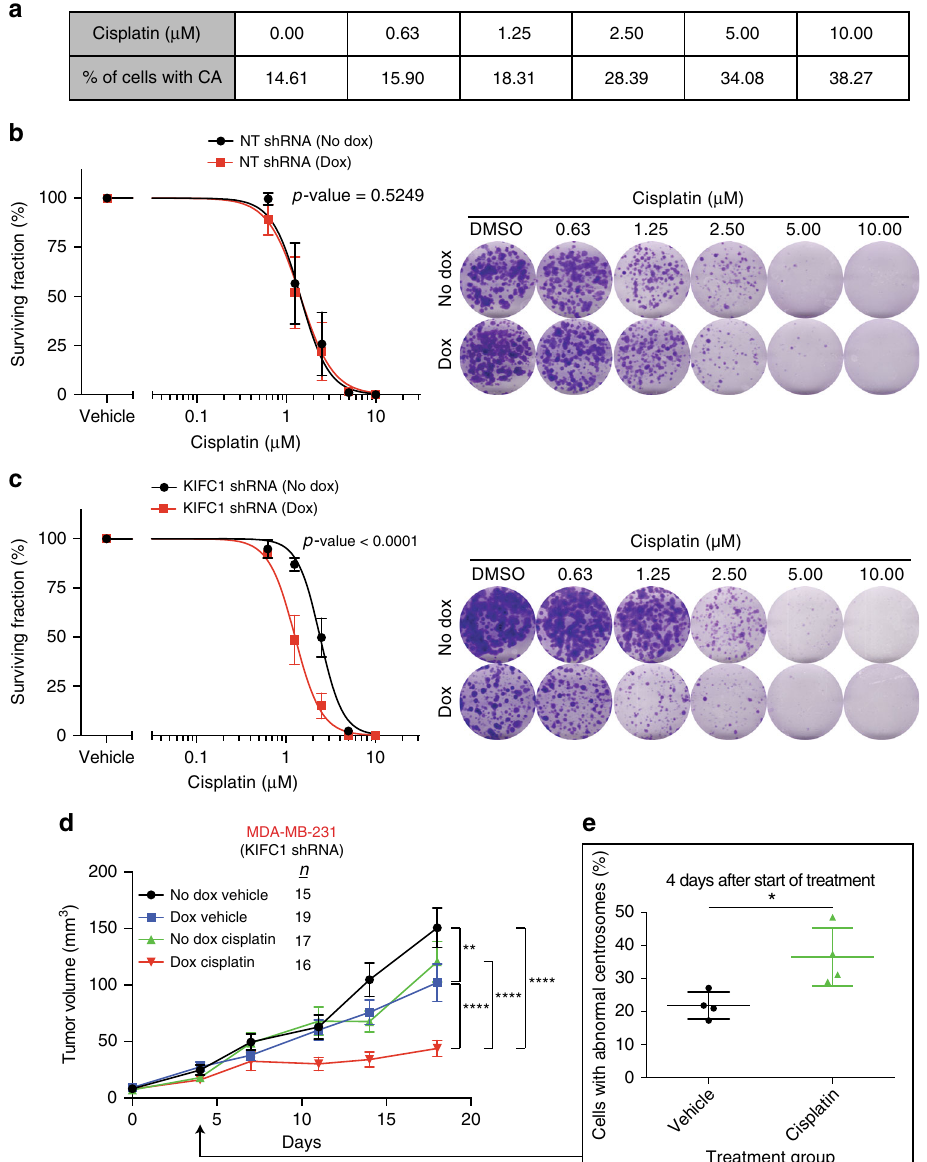
Fig. 6 Therapeutic induction of centrosome ampli fi cation in tumors increases the ef fi cacy of KIFC1 silencing. a MDA-MB-231 cells were treated with fi ve serial concentrations of cisplatin and DMSO control and scored for centrosome ampli fi cation (CA). Table shows the level of CA at each concentration of cisplatin. b Surviving fraction of MDA-MB-231 cells with inducible NT shRNA with (red) or without (black) doxycycline. Data points represent the mean, error bars represent the SEM, n = 3. Extra sum-of-square F -test ( F -value 0.41). Right, representative images of colony formation wells for each treatment condition. c Surviving fraction of MDA-MB-231 cells with inducible KIFC1 shRNA with (red) or without (black) doxycycline. Data points represent the mean, error bars represent the SEM, n = 3. Extra sum-of-squares F -test ( F -value 57.59). Right, representative images of colony formation wells for each treatment condition. Note, fi ve times more MDA-MB-231 cells with KIFC1 shRNA (Dox) were plated due to low colony forming ability of cells without KIFC1. d Nude hosts were injected with MDA-MB-231 cells with inducible KIFC1 shRNA and were treated with or without doxycycline and either vehicle or 5 mg kg − 1 of cisplatin when tumors reached >2 × 2 mm or 4.2 mm 3 . Mean tumor volume at time points indicated, error bars represent the SEM, from